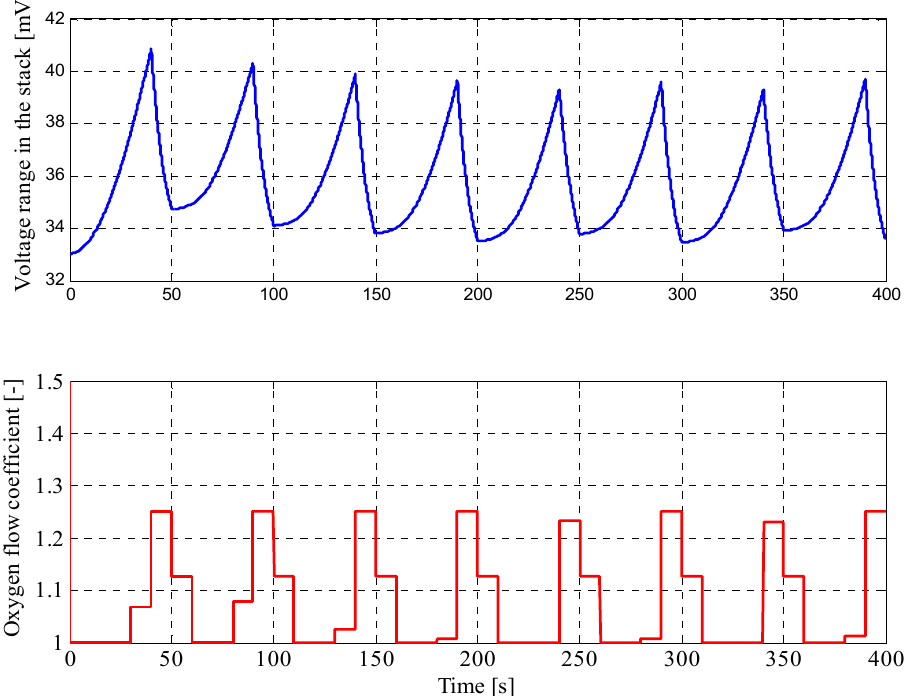
Figure 15. Voltage range and oxygen flow coefficient for the fuzzy control procedure with simulation parameters set to R U , z = 38 mV and ∆ t = 10 s (initial R U = 33 ( mV ) , k O